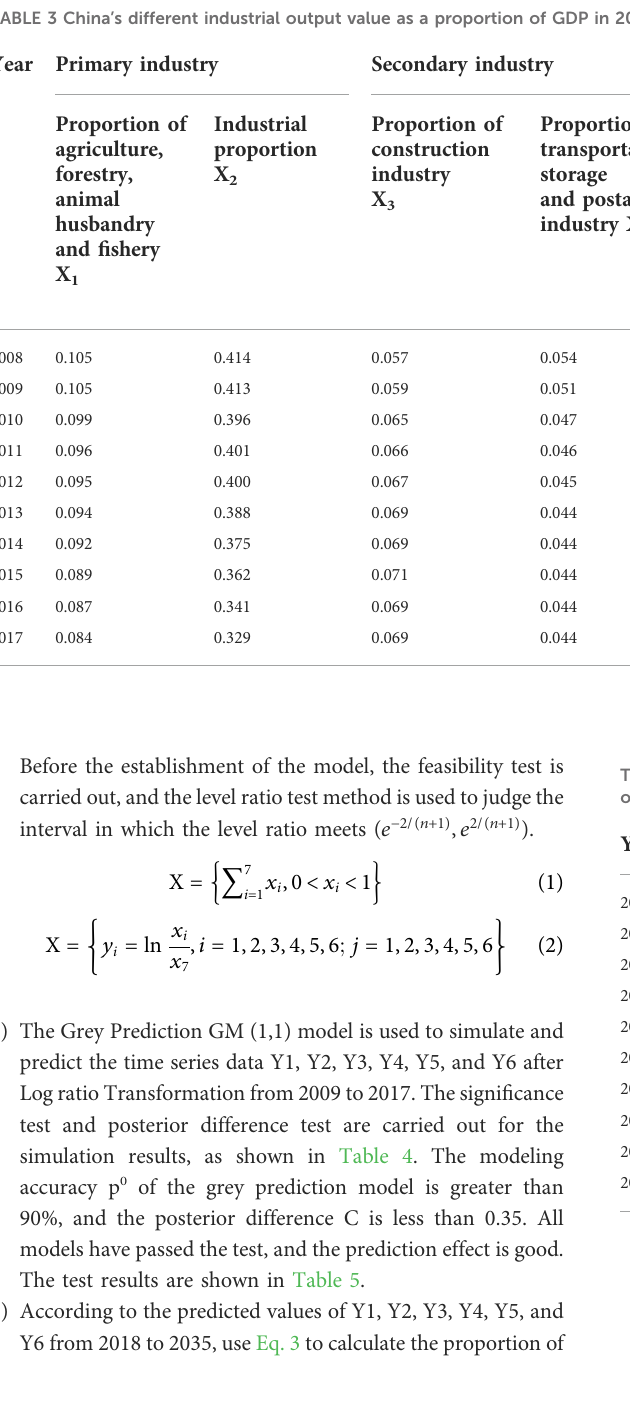
TABLE 3 China ’ s different industrial output value as a proportion of GDP in 2008 – 2017.